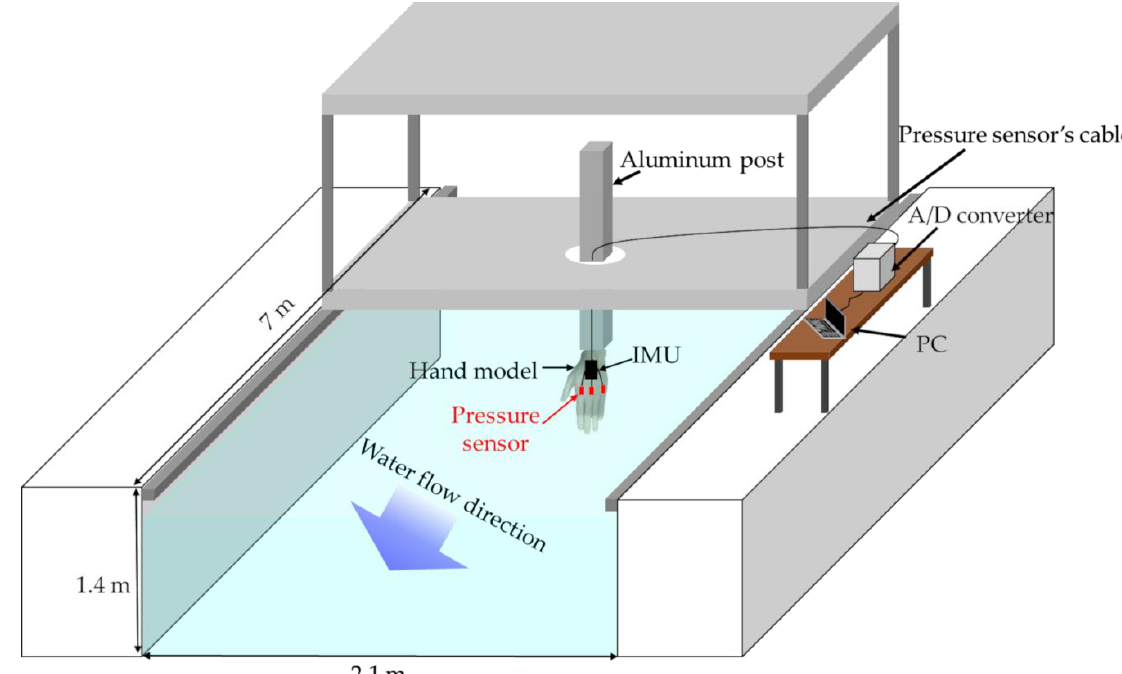
Figure 3. Schematic diagram showing experimental environment for Experiment